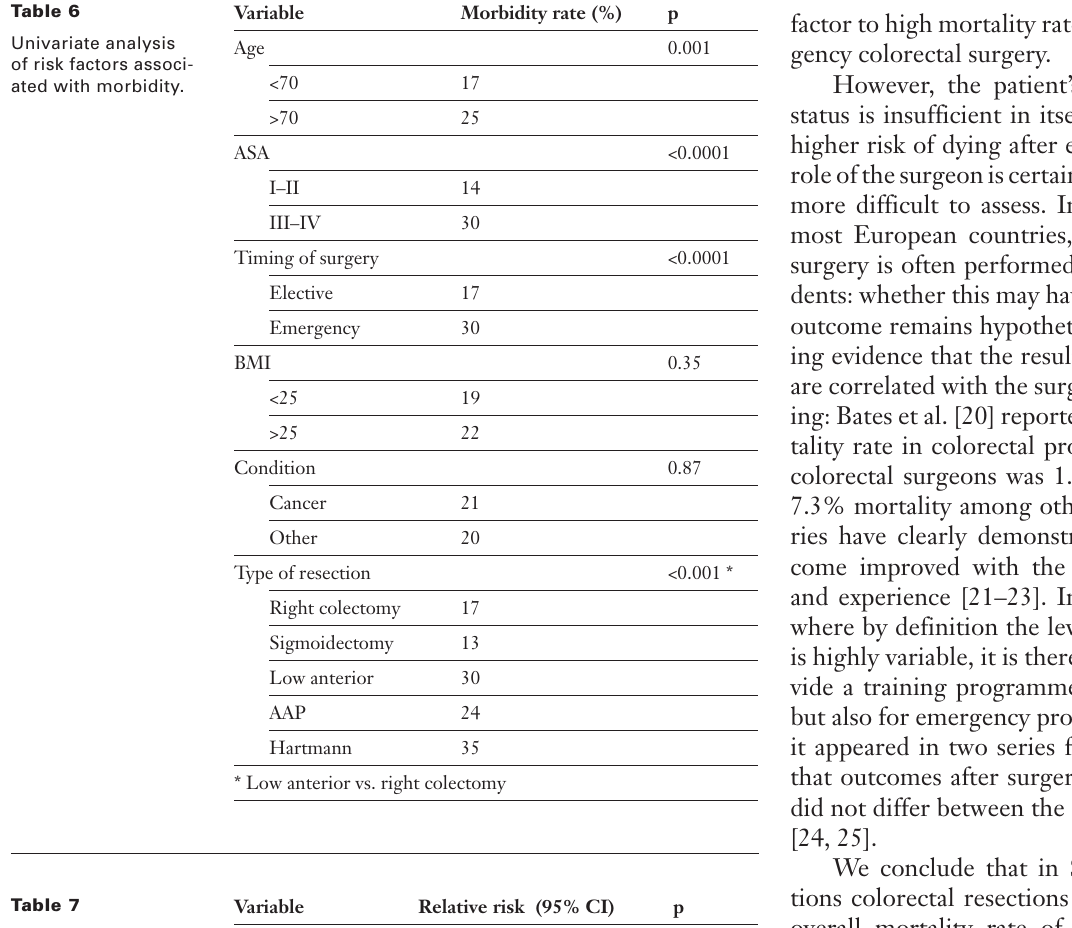
Multivariate analysis of risk factors associ- ated with mortality.